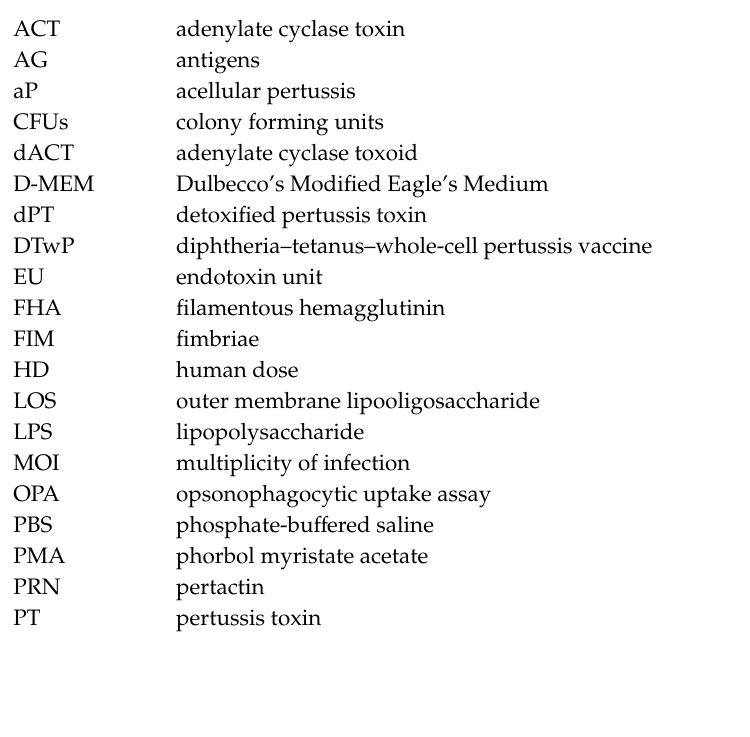
Figure S1: Determination of the aP vaccine dose conferring a limited protection against intranasal B. pertussis challenge in BALB / c mice. Figure S2: Neutralization of toxin activities of ACT by sera of immunized mice. Figure S3: Total serum IgG antibody responses to the five vaccines